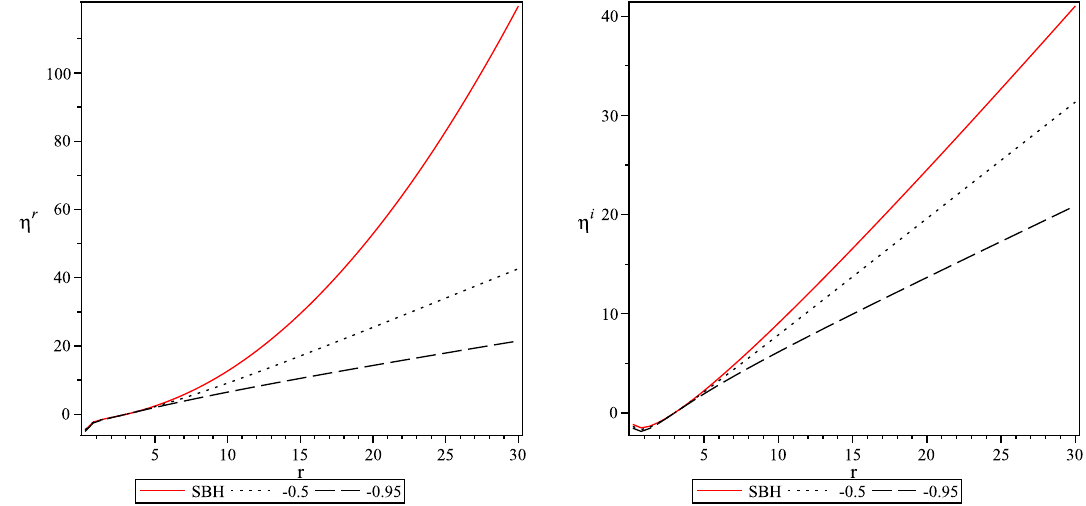
Fig. 5 Variation of geodesic vectors for M = 1, q = 0 . 05, a = 0 . 3 and different mentioned values of w q ; left figure: radial geodesic vector with ICII, right figure: angular geodesic vector with ICII; solid line curve represents the corresponding variation for SBH